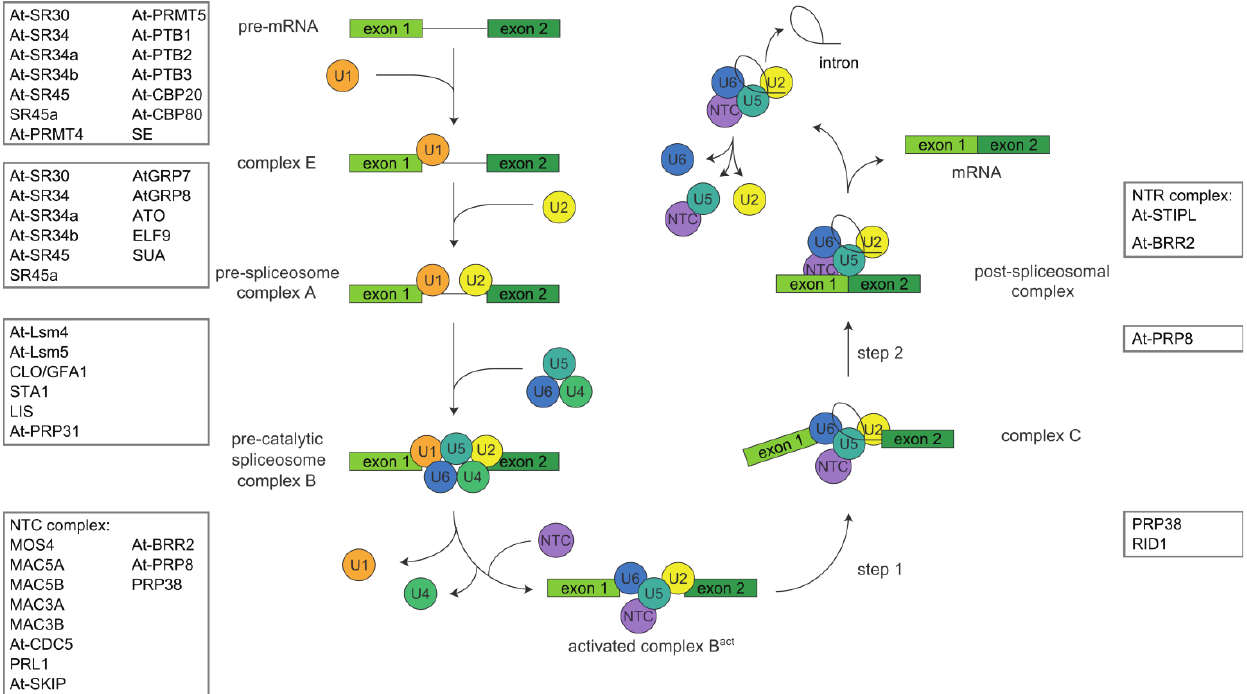
Figure 2. The spliceosomal cycle. The splicing process is initiated by the interaction of the U1 snRNP with the 5' splice site through base pairing of the U1 snRNA to complementary sequences. The U2AF subunit U2AF 35 binds to the intron/exon border and the subunit U2AF 65 binds to the polypyrimidine tract upstream of the intron/exon border, leading to the complex E. Subsequently, the U2 snRNP binds to the branch point, defining complex A. The U4/U6.U5 snRNP is then docked onto the U2 snRNP, leading to the